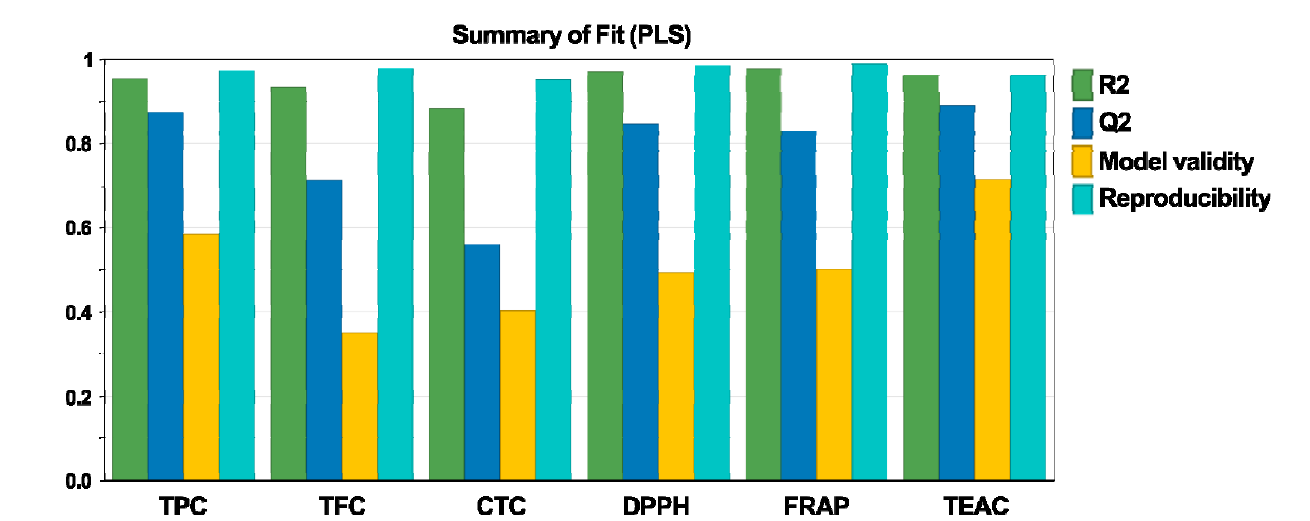
Figure 1. Fitting of experimental data using the partial least squares (PLS) model.